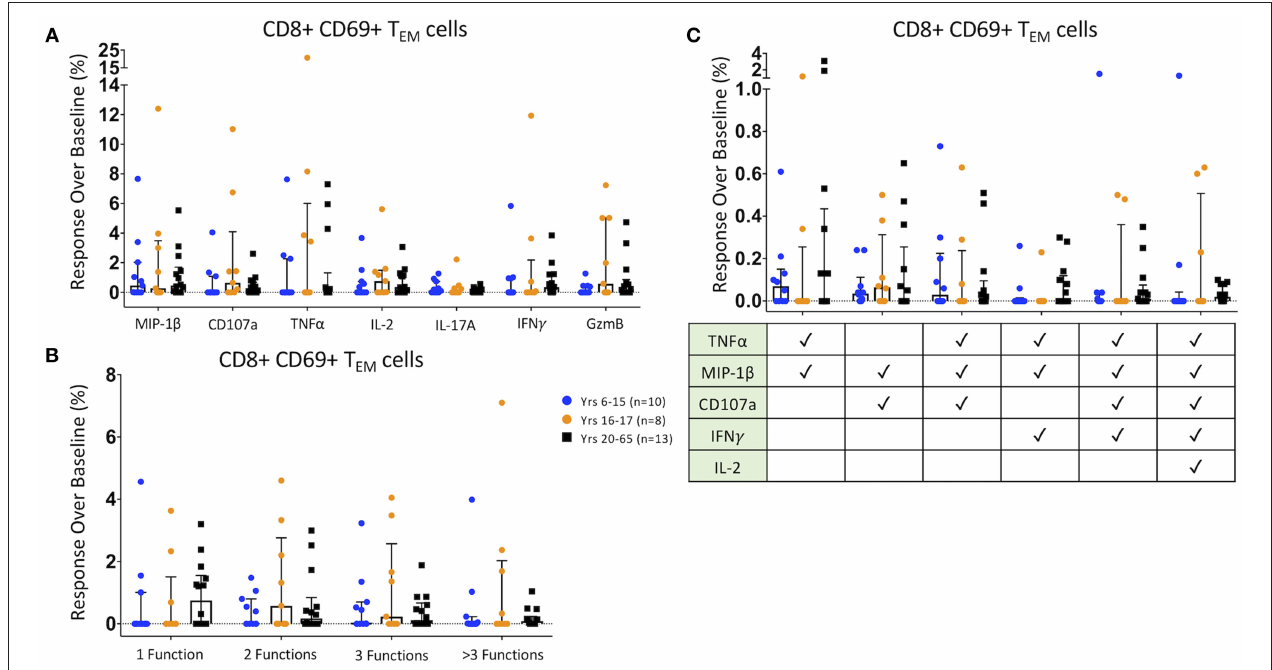
FIGURE 3 | CD8 + T Effector Memory Responses. Scatter plots showing (A) the responses over baseline percentages of CD8 + CD69 + T EM producing/expressing MIP1 β , CD107a, TNF α , IL-2, IL-17A, IFN γ , and Granzyme B (GzmB); (B) CD8 + CD69 + T EM observed mono-, bi-, tri-, and > 3-functional populations; and (C). specific CD8 + CD69 + T EM selected multifunctional responses following co-culture with HLA-E restricted S . Typhi infected antigen presenting targets. These MF populations were selected based on those shown in a previous S. Typhi challenge study to be associated with protection from developing disease (10, 11). Bars represent medians with whiskers indicating interquartile ranges. Results are shown for the following populations: 6–15 year-old pediatric ( n = 10), 16–17 year-old pediatric ( n = 8), and adult ( n = 13) participants. Scatter plot statistics were analyzed by unpaired t -test. (* p <